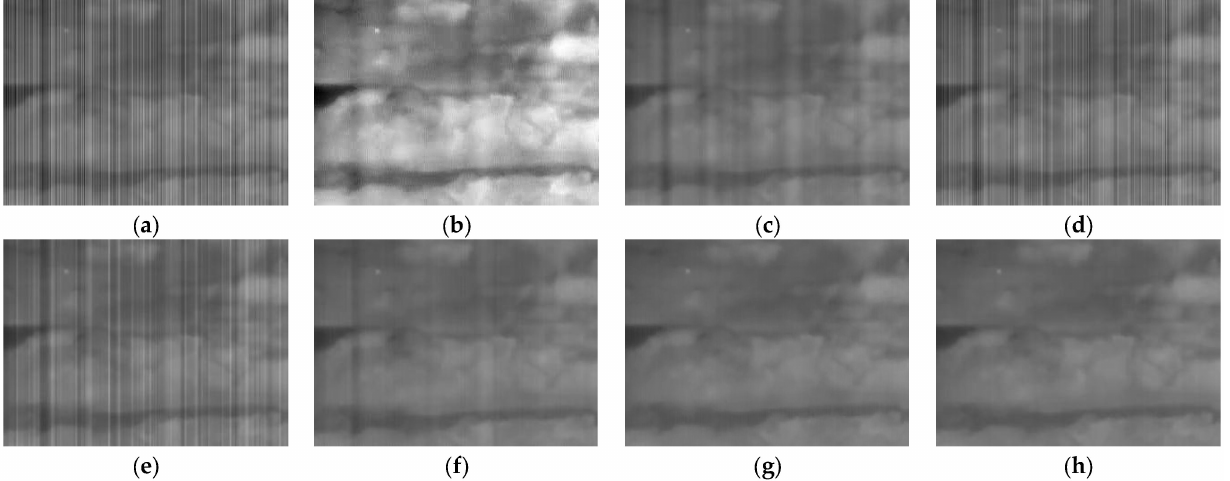
Figure 9. Comparison of methods using medium-intensity nonuniformity infrared dim small tar- get images: ( a ) infrared dim small target image with medium-intensity nonuniform noise added; ( b ) MHE; ( c ) 1D-GF; ( d ) SNRCNN; ( e ) ICSRN; ( f ) DLS-NUC; ( g ) SNRWDNN; ( h )